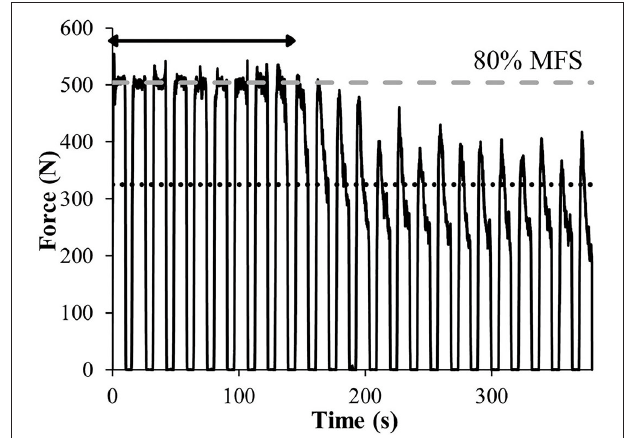
FIGURE 2 | Illustration of one participant during the fatigue test performed on the SmartBoard (A) , on the 12mm hold. The feedback of the force level was displayed on the tablet (B) so that the participant can adjust the level of force intensity required during the test/training by using his feet on the